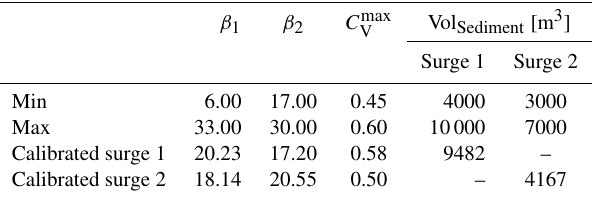
Table 1. Calibrated parameters and their range for surges 1 and 2. Parameters for both surges were expected to be different because of the equifinality and their different sedimentologic